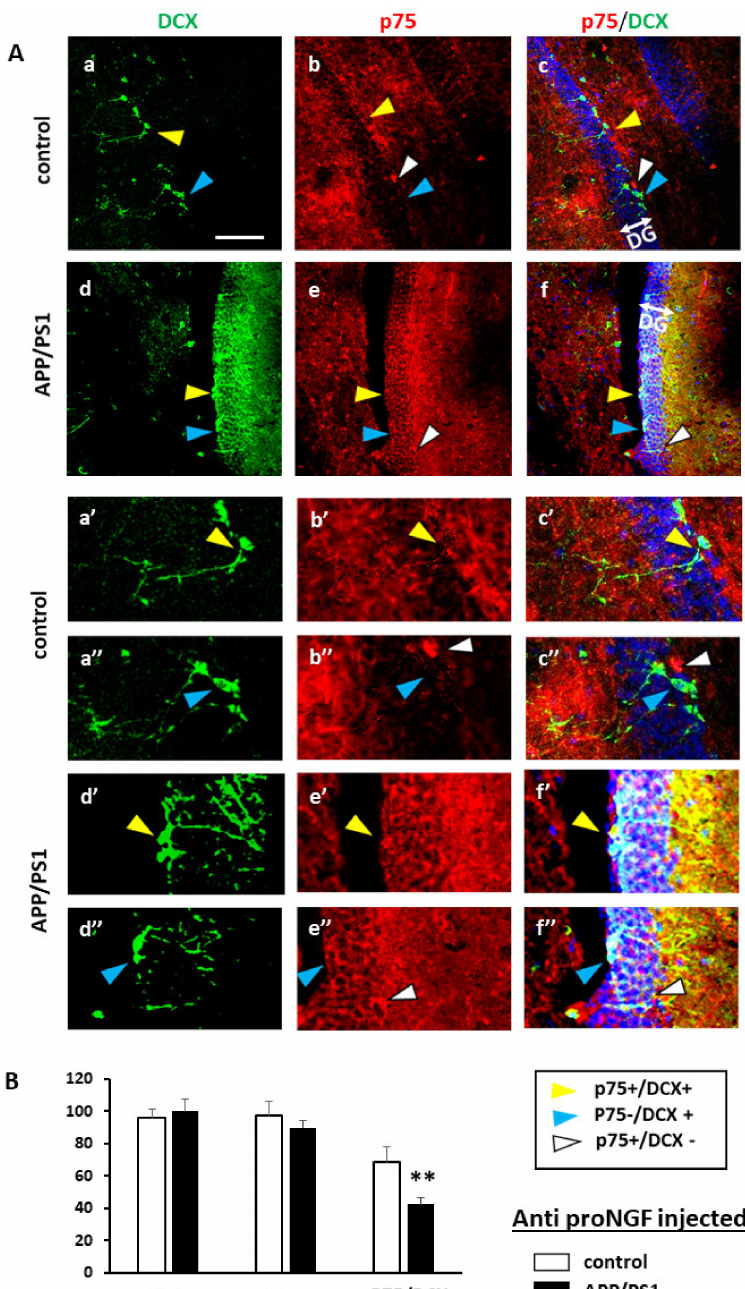
Figure 5. Neurogenesis is increased in the DG of APP/PS1m mice injected with anti-proNGF antibody. ( A ) Confocal images representing immunoflurorescence pictures showing colocalization of p75 and DCX in the control ( a – c ) and AD ( d – f ) groups. DAPI (blue), p75 (red), DCX (green). Controls showing greater colocalization of DCX and p75 than APP/PS1 transgenic mice. Example of colocalization of DCX and p75 compared to AD samples (yellow arrow), DCX+ and p75- cells (blue arrow) and DCX-and p75+ cells (white arrow). Scale bar = 15 µ m. Pictures with quotation marks correspond to amplifications of the corresponding letters; ( B ) Bars represent the mean of % positive cells ± SD respect to DAPI stained cells per field or % of p75NTR+ on the DCX positive cells (p75/DCX) in the DG of APP/PS1 mice and controls. Positive cells are considered those with staining in the cell body. Values are expressed as the percentage of the highest mean. Enough pictures at 40 × were randomly selected to cover 300 DAPI positive neurons. ( n = 5 mice per group). p ≤ 0.01